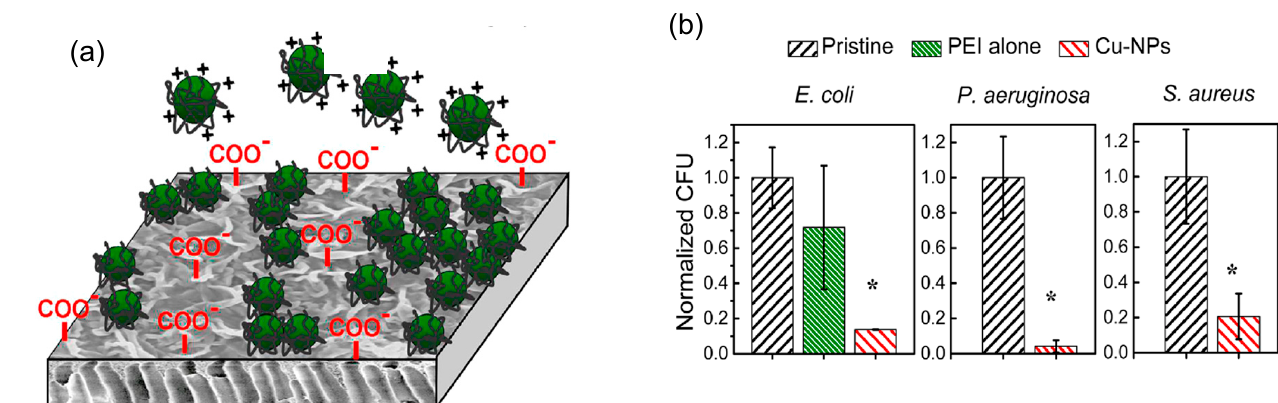
Figure 3. Results of the functionalization of TFC-RO membranes with Cu-NPs reported by Ben-Sasson et al. [32]. ( a ) Schematic of the electrostatic binding between the Cu-NPs (positively charged) and the carboxyl groups (negatively charged) on the active layer of the pristine membrane. ( b ) Biocide capacity comparison between the pristine membrane (black) and modified with the capping agent (PEI) alone (green) and Cu-NPs (red) over E. coli , P. aeruginosa (gram negative bacteria) and S. Aureus (gram positive bacteria). Asterisks (*) indicate a statistically significant difference between the functionalized and pristine membranes ( p < 0.05). Adapted from